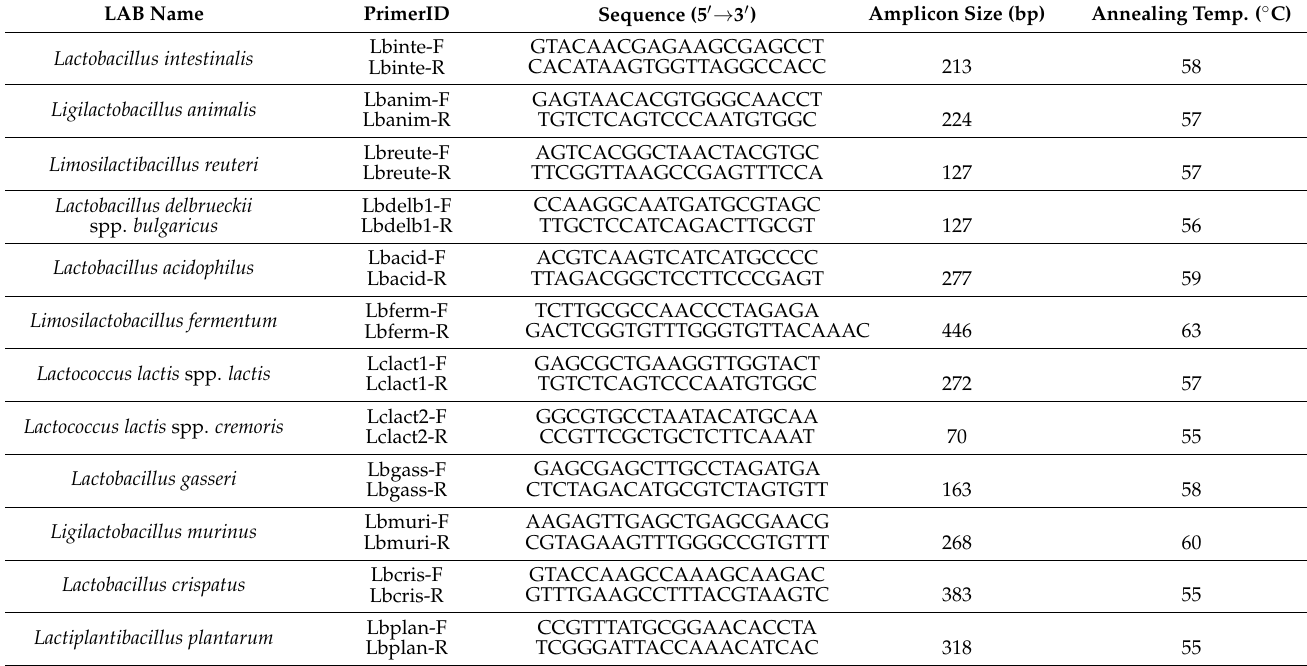
Table 1. Species-specific primers were used for the identification of isolated LAB strains from the mouse intestinal